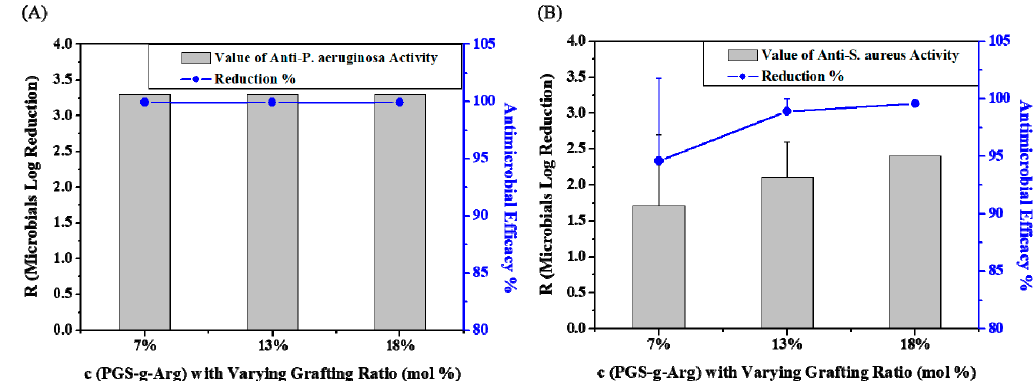
Figure 6. The capability of ( A ) anti- Pseudomonas aeruginosa and ( B ) anti- Staphylococcus aureus of c(PGS-g-Arg) films ( n = 2).